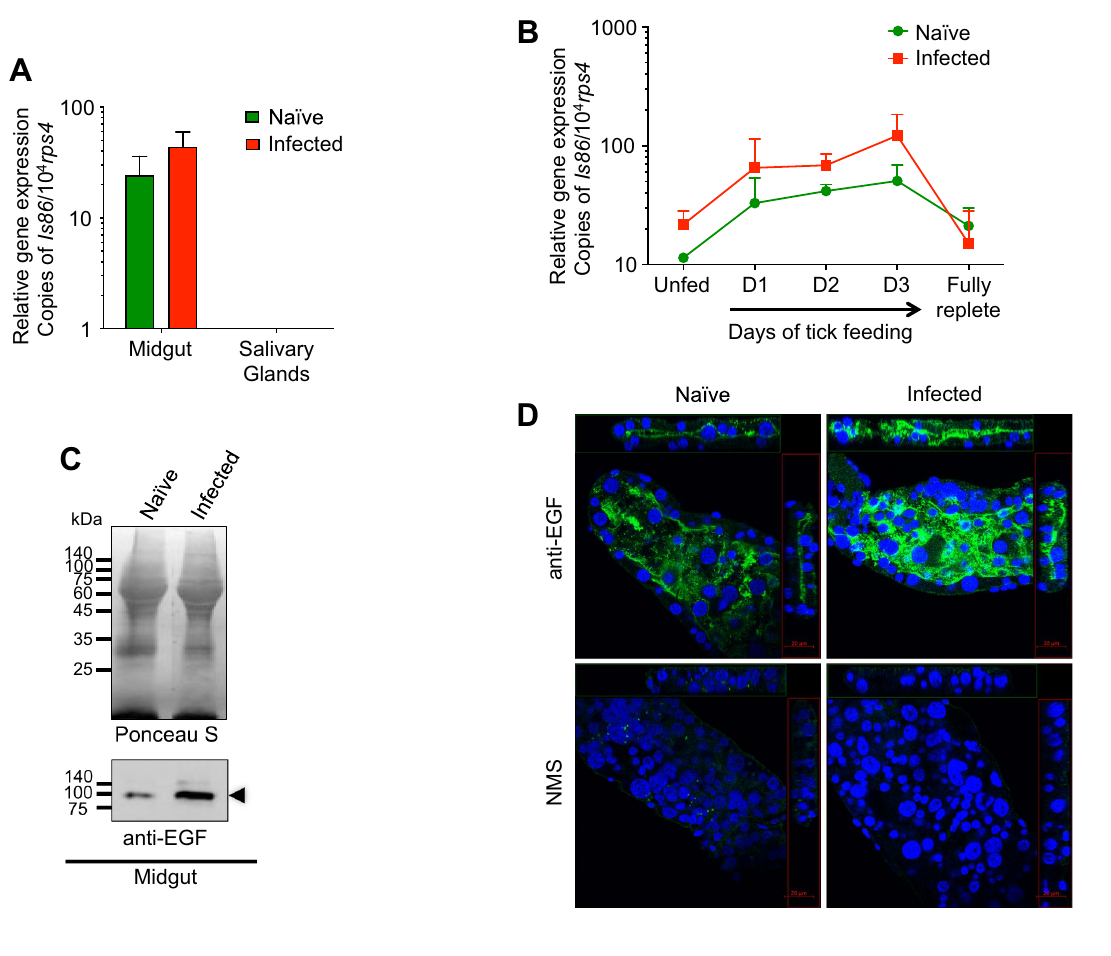
Figure 2. Expression and localization of Is86 in I. scapularis ticks. ( A ) Gene expression of Is86 in ticks. The naïve and B. burgdorferi -infected nymphal ticks were collected during feeding (at days 1, 2, and 3 of feeding, and when fully replete). The tick guts and salivary glands of unfed and fed ticks were dissected and pooled together according to tissue type. Is86 gene expression was measured by using qPCR and normalizing against the tick house-keeping gene rps4 . ( B ) Kinetic Is86 expression over the course of tick feeding. Naïve and B. burgdorferi -infected ticks were collected at the indicated time points during feeding. Is86 gene expression was measured by using qPCR and normalizing against tick rps4 . The results are presented as the median ± SEM from two independent experiments. ( C ) Is86 protein expression is induced in B. burgdorferi -infected tick guts. The proteins from naïve and B. burgdorferi -infected nymphs (pooled unfed and two-day fed guts) were either stained with Ponceau S to show an equal protein loading (upper panel) or probed with pooled antisera against Is86 EGF domains (lower panel). The arrowhead indicates Is86 immunoreactivity, which is notably induced in spirochete- infected guts, in comparison to naïve tick guts. For an image of the full-length immunoblot, please refer to Fig.S6. ( D ) Is86 is localized towards the luminal surface of the unfed tick gut. Unfed tick guts were stained with anti-EGF (green) or normal mice serum (NMS), and the nuclei were stained with DAPI (blue) and visualized under the confocal microscope. The representative images are composites of